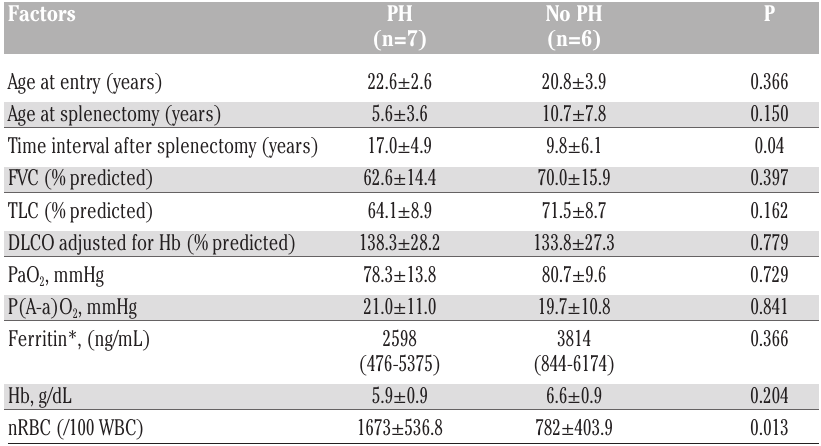
Table 3. Factors associated with development of pulmonary hypertension in splenec- tomized patients(data are expressed as mean ±